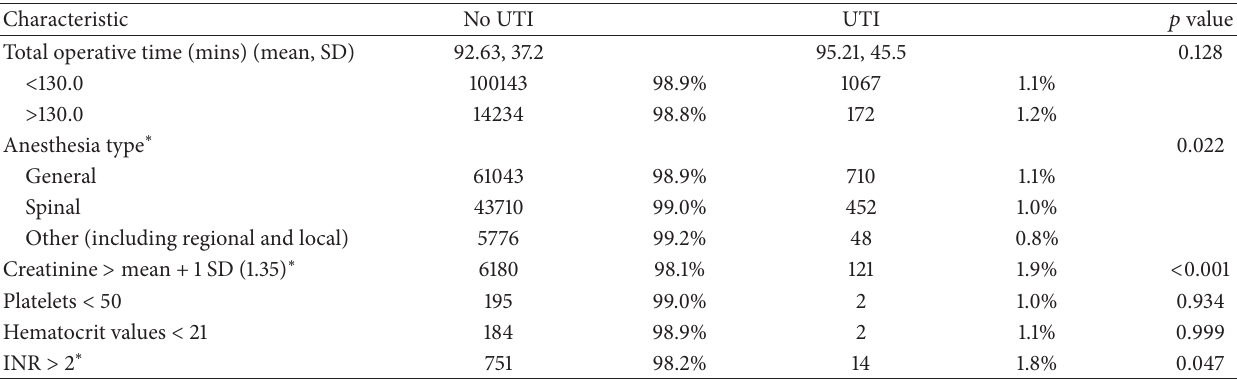
Table 2: Operative and lab characteristics.